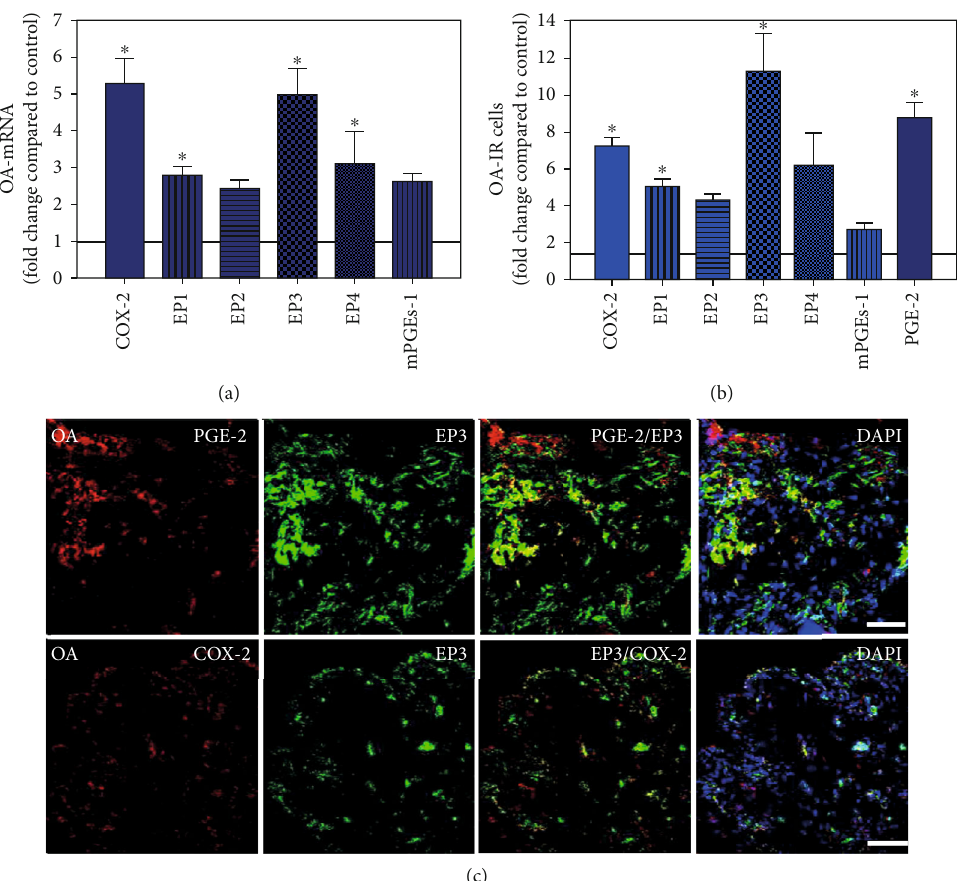
Figure 9: Detection of mRNA (a) and the number of cells immunoreactive for di ff erent components of the prostanoid system (PGE2, mPGES, COX-2, and EP1-4) (b) in patients with osteoarthritis (OA). (a) Quanti fi cation of mRNA speci fi c for COX2, EP1-4, and mPGEs- 1 in synovium of OA patients. (b) Quantitative analysis of COX2-, EP1-4-, and mPGEs-1-IR cells in OA synovium. Data are shown as means ± SEM . (c) Confocal microscopy of EP3 (red fl uorescence; a, b) and mPGES or COX2 (green fl uorescence; c, d) double immuno fl uorescence (e – h) in OA synovium. Bar = 40 μ m . DAPI blue fl uorescence shows nuclear staining. Bar = 40 μ m